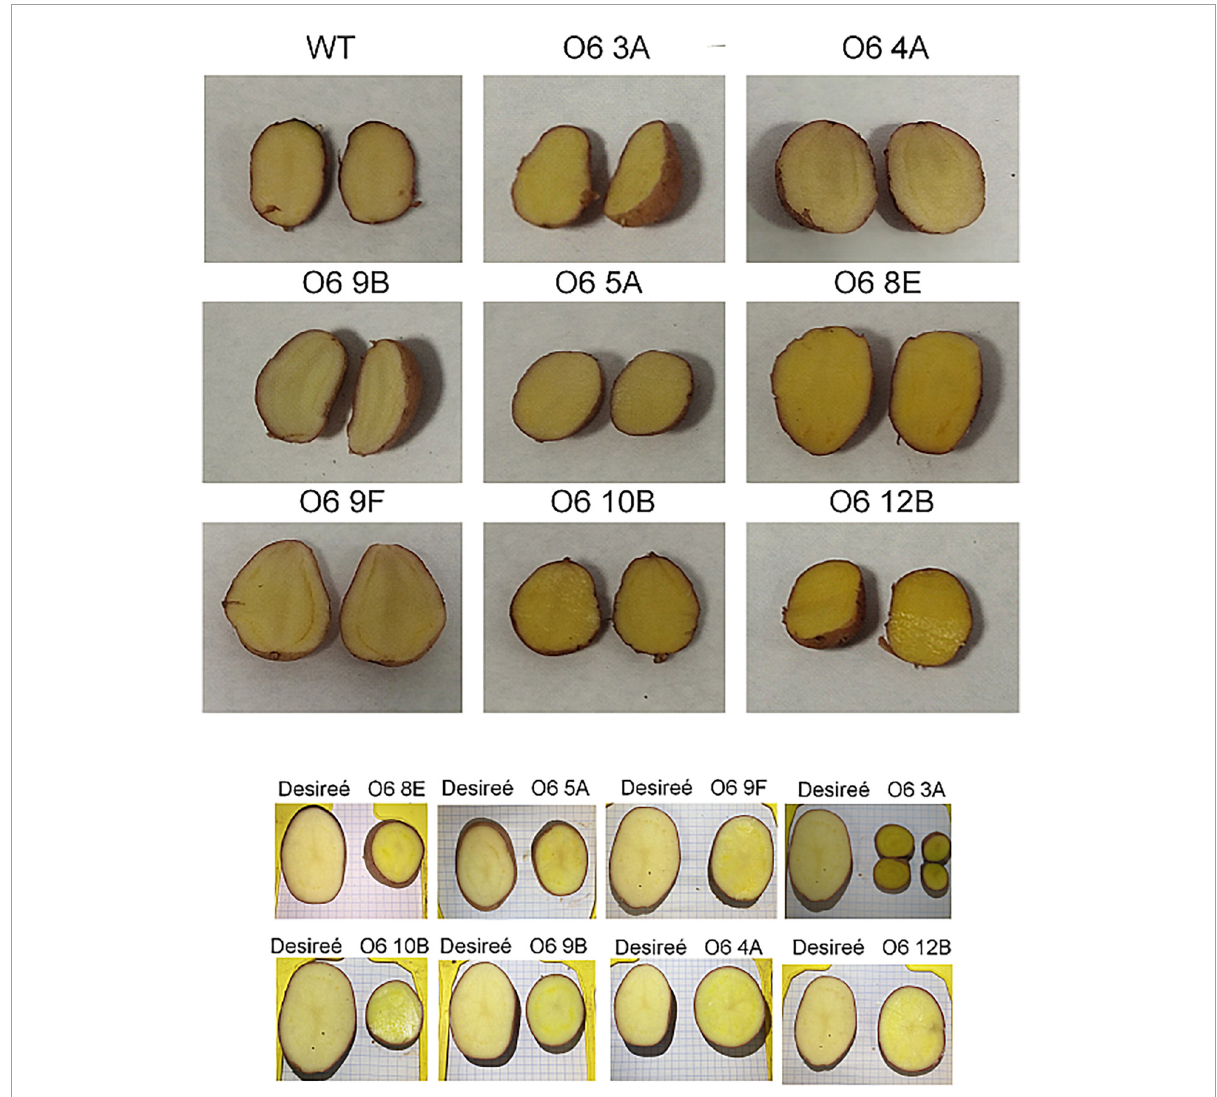
FIGURE1 Potato wild type (Cv desirée) and transgenic lines accumulating the characteristic apocarotenoids in